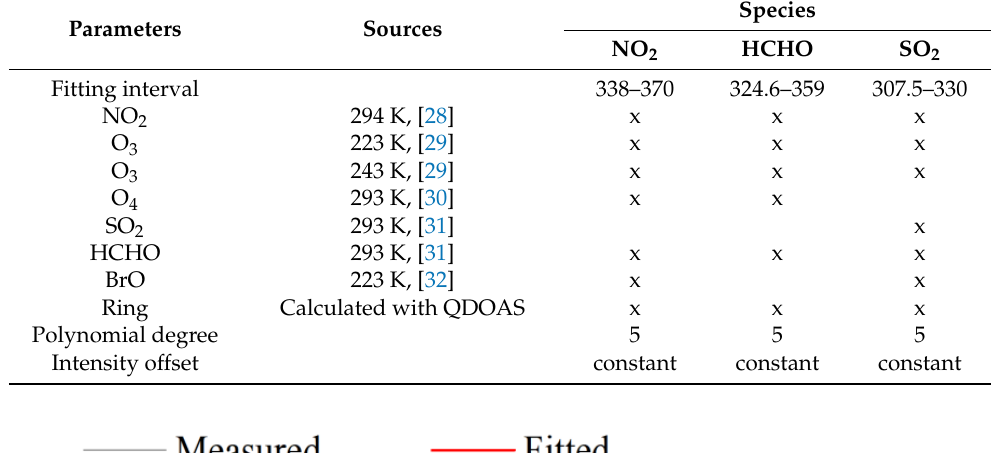
Table 1. Parameter settings used for spectral analysis using QDOAS.